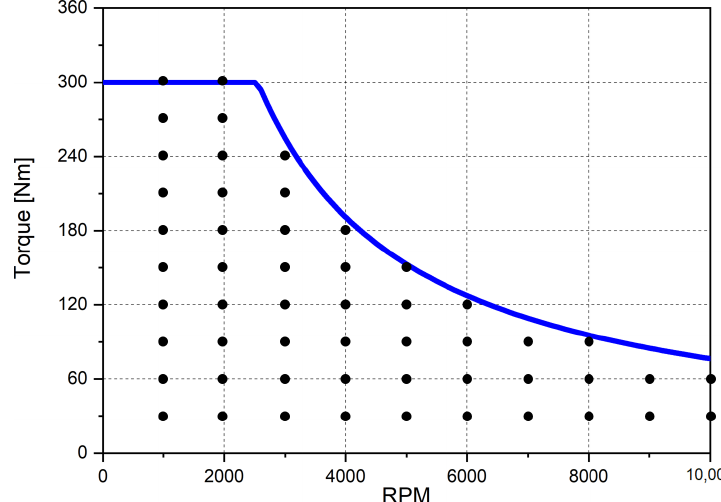
Figure 13. Analyzed operating points of the propulsion IPMSM.